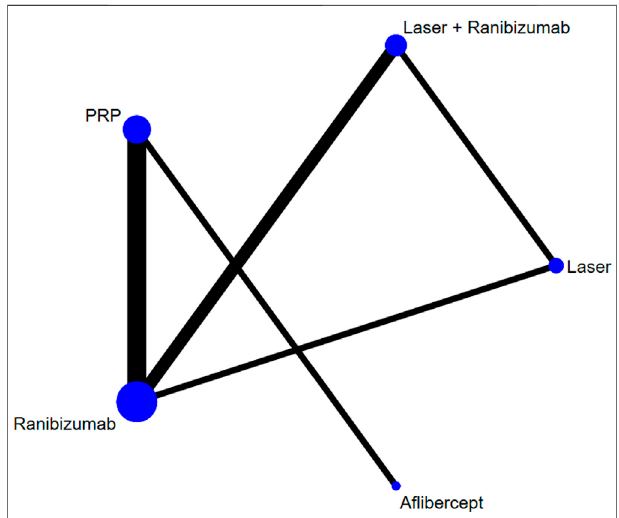
FIGURE 2 | Network of comparisons of various treatments for vision score change. Seven studies involving 1,136 eyes were included. Five interventions were included to form a closed loop. Each circle indicates a treatment node. The size of the nodes is proportional to the number of trials evaluating each treatment. Lines connecting two nodes represent direct comparisons between two treatments. The thicker the number of lines between nodes, the more